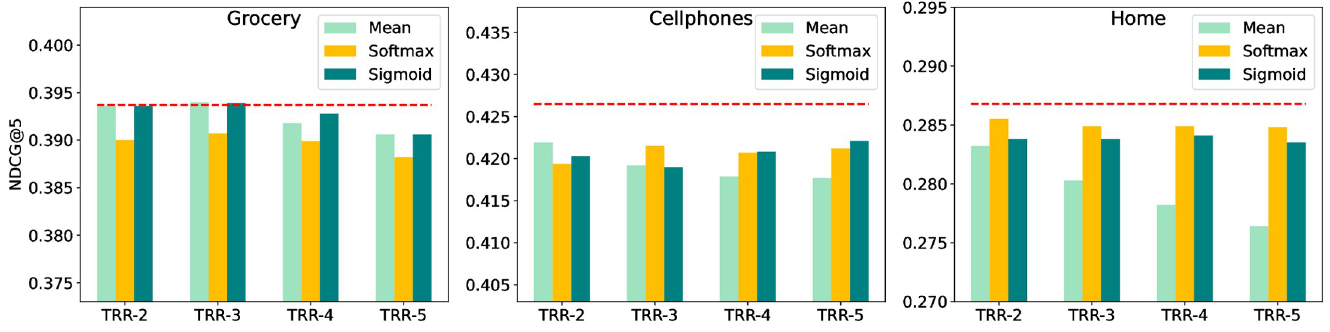
Fig 5. The impact of different relational item number n within three aggregating methods (NDCG@5).